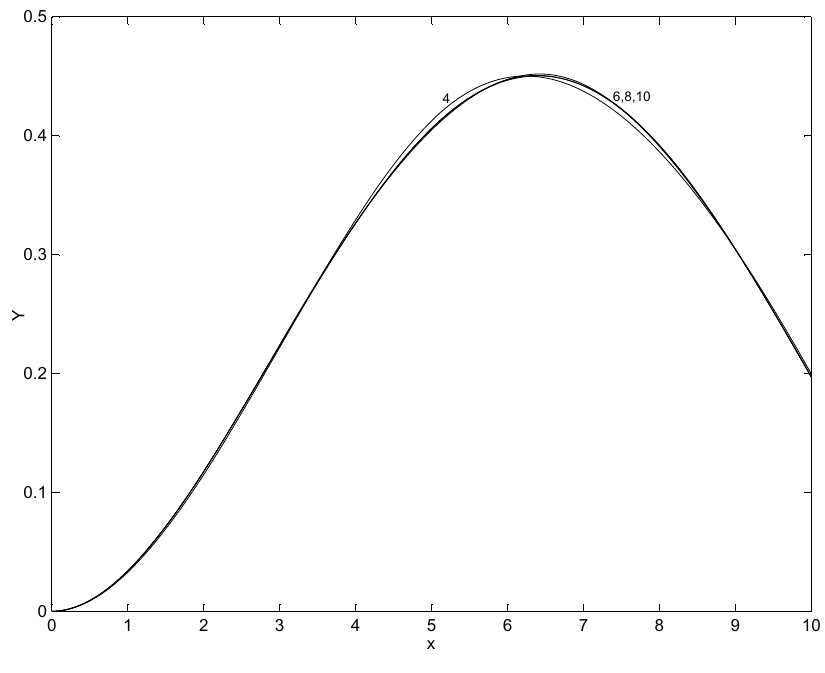
Fig. 3. FEM first eigenfunction convergence (4, 6, 8, 10